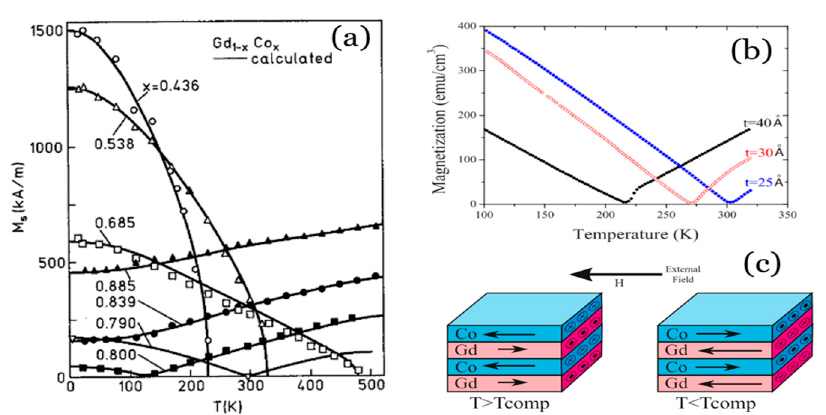
Figure 4. ( a ) Magnetization of GdCo alloys of several compositions. Reprinted with permission from ref. [23]. 1989 AIP. ( b ) Magnetization of GdCo/Co ferrimagnetic multilayers showing different T comp depending on the thickness of Co layers (labeled in the graph). Reprinted with permission from ref. [25]. 2008 APS. ( c ) Outline of the aligned states of a Gd/Co multilayer at temperatures below and above T comp , where the dominating sublattice changes.